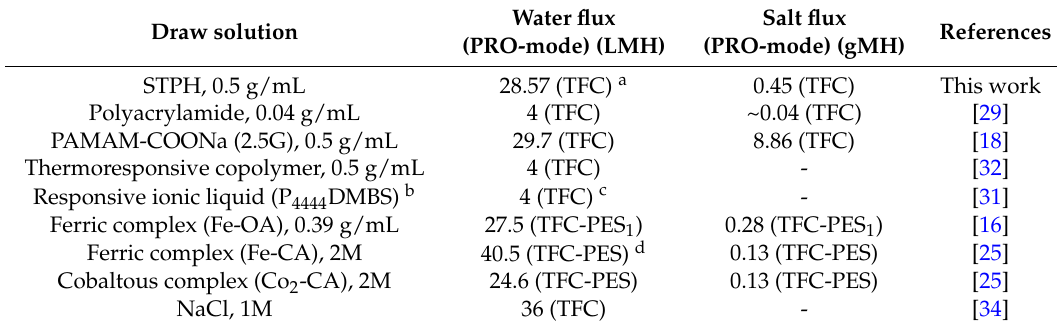
Table 1. Benchmarking of the forward osmosis (FO) performance using different draw solutions. Sodium tetraethylenepentamine heptaacetate: STPH; Polyamidoamine with terminal carboxyl